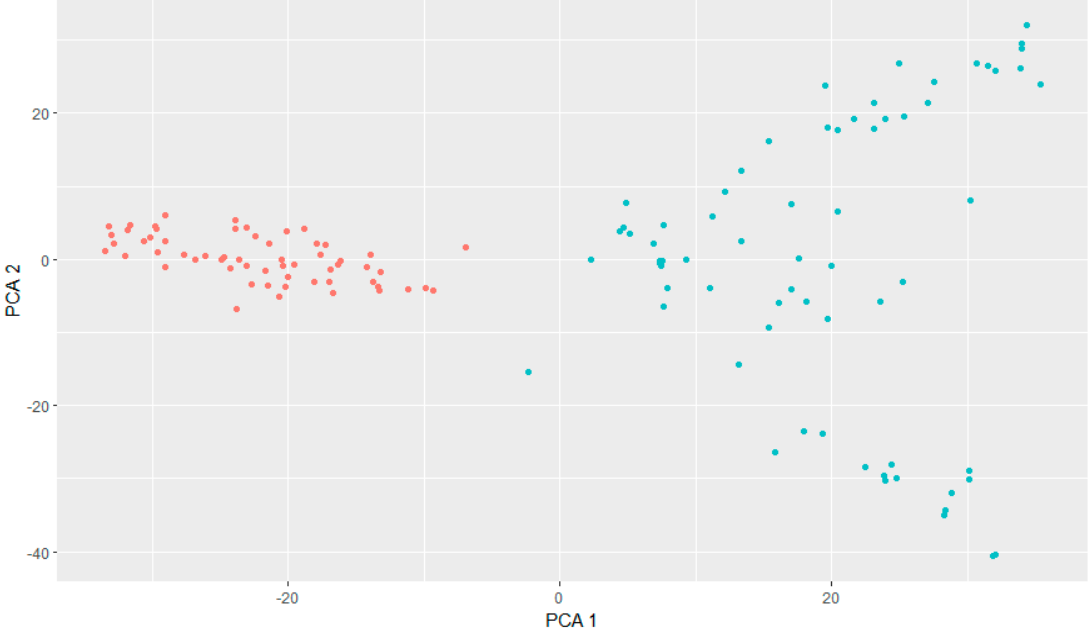
Figure 1. Principal component analysis (PCA) plot of sunflower lines based on Restriction site associated DNA (RAD) sequencing data. Pink dots–sterility maintainers, blue dots–restorer lines.